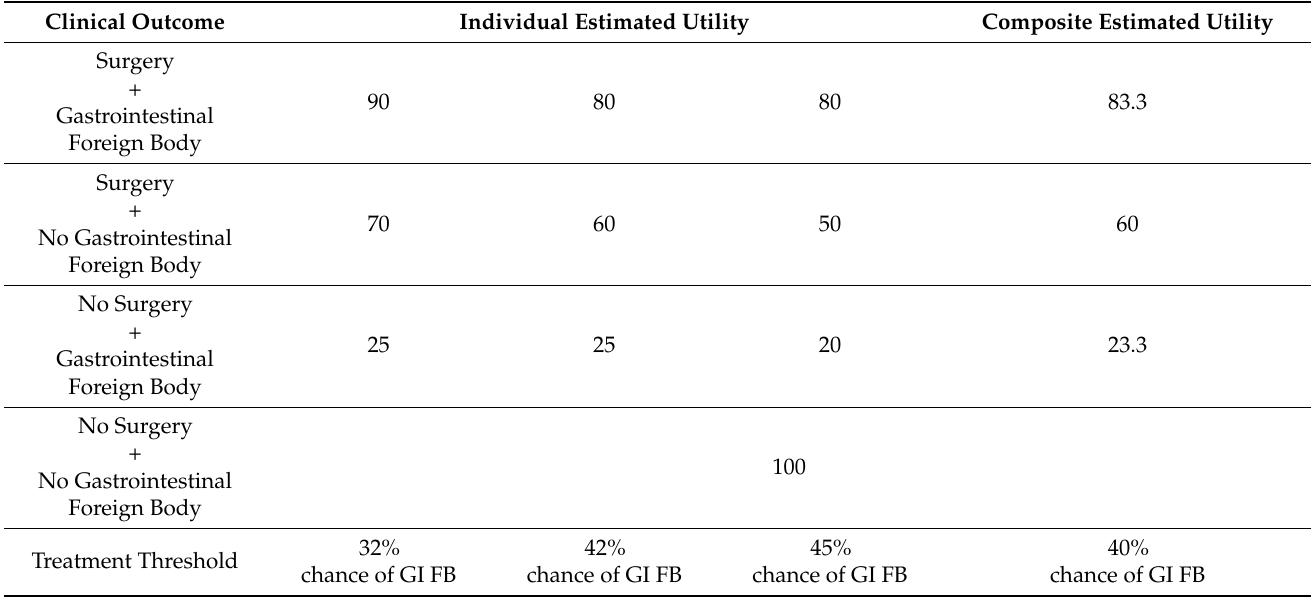
Table 3. Individual and composite (average) estimates of relative utility for different clinical outcomes from the original clinical team. The utility for no surgery + no gastrointestinal foreign body was assumed to be 100